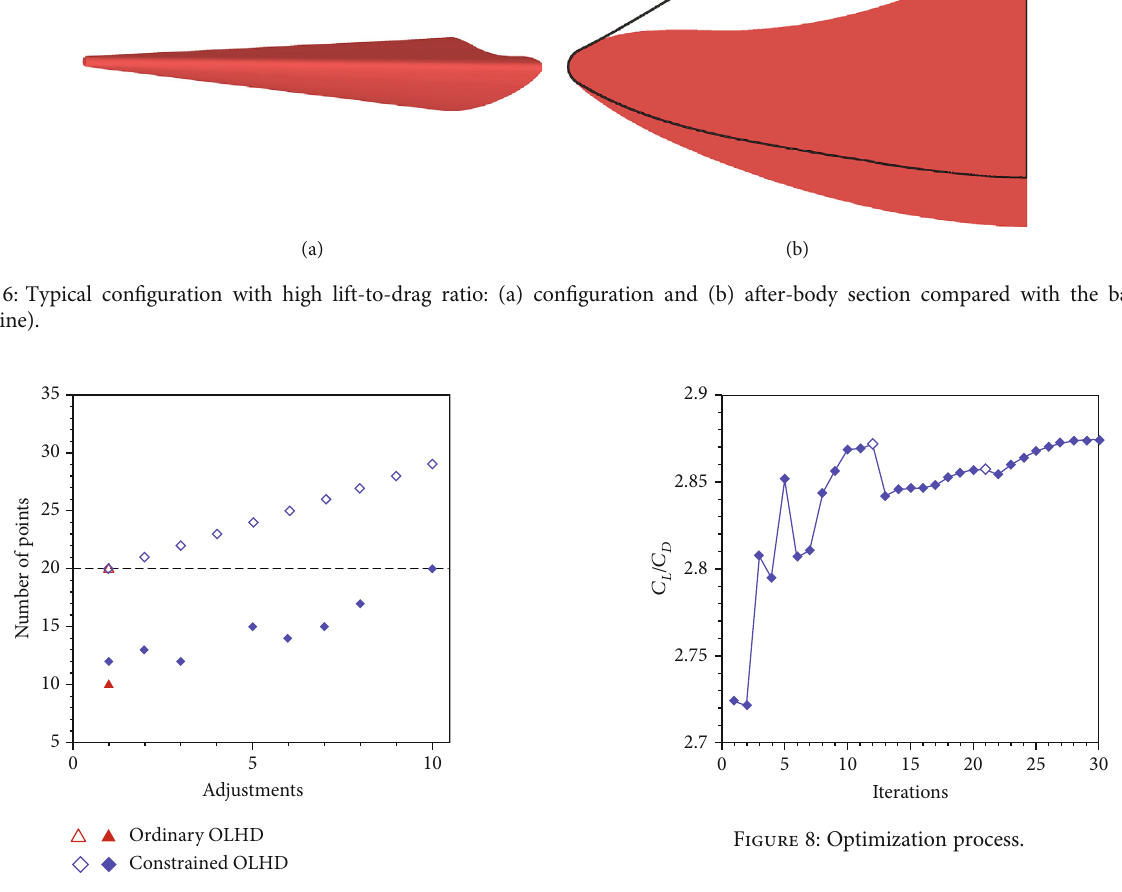
Figure 7: Sequential adjustments of the constrained OLHD. Table